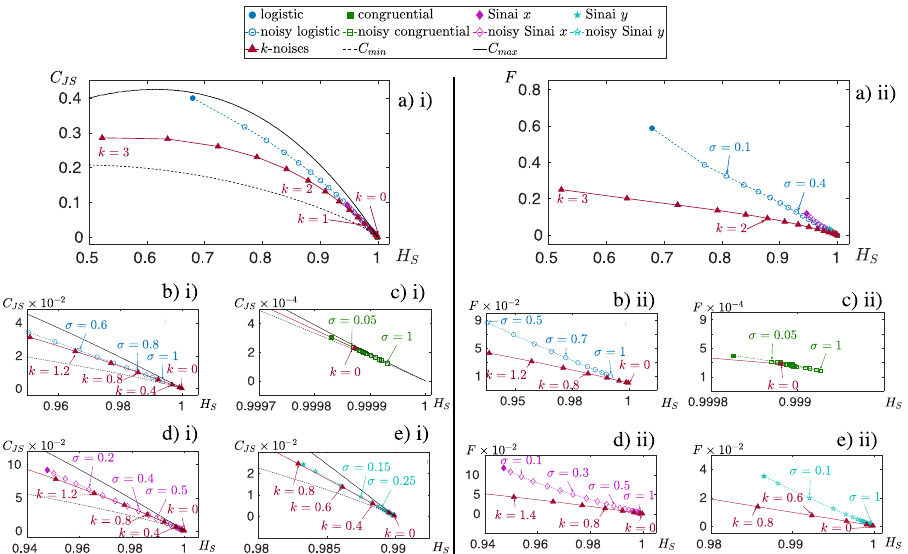
Fig. 6 Global versus local representation planes. Localisation of the k -noises ( k ∈ [0, 3] with step 0.2) and chaotic maps in the ai permutation complexity – entropy plane and aii Fisher-entropy plane. Additive noise with σ ∈ [0, 1] with step 0.05 is been depicted. Noise-free sequences (solid symbols). Noisy sequences (open symbols). Zoom of individual maps near the stochastic zone: bi , bii logistic map, ci , – cii congruential map, di , dii x -Sinai and ei , eii y -Sinai. k : correlation degree and σ : intensity of the noise